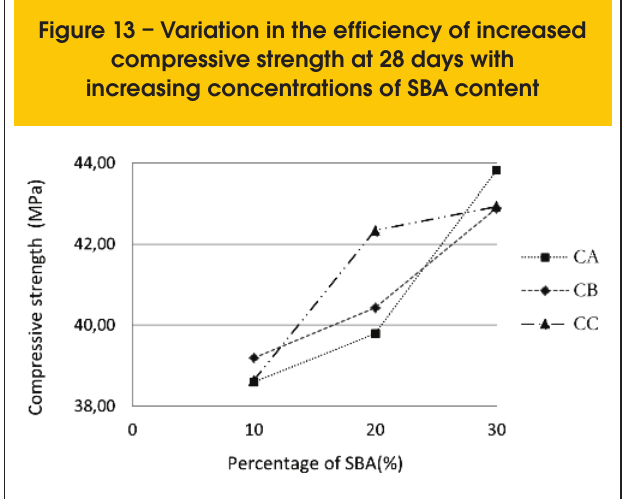
Figure 13 – Variation in the efficiency of increased compressive strength at 28 days with increasing concentrations of SBA content